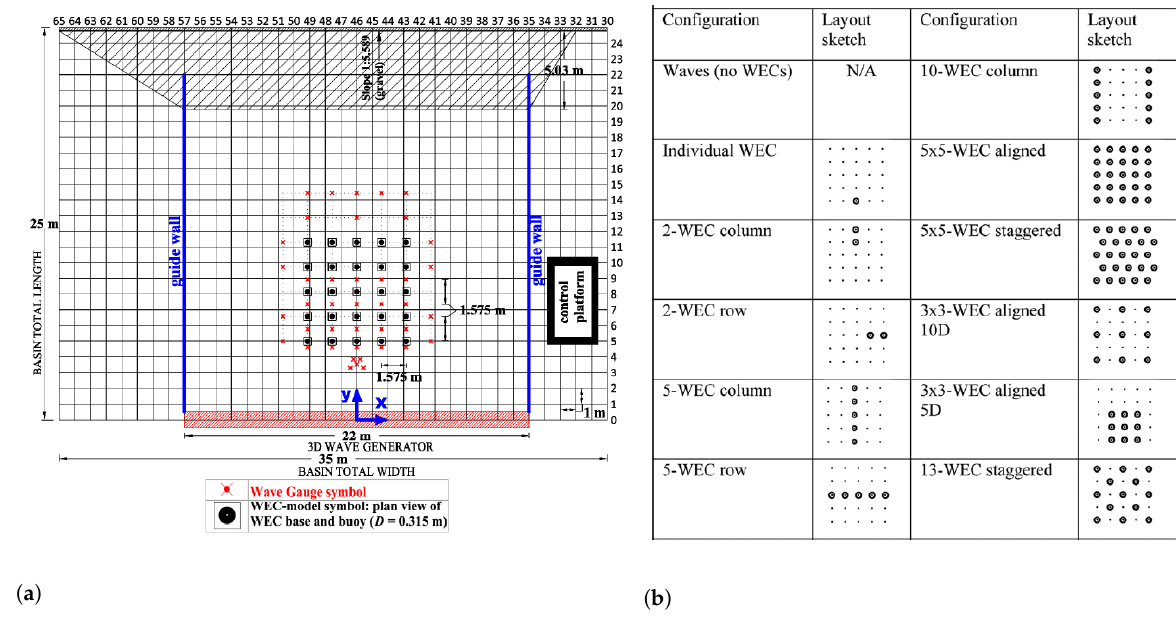
Figure 8. Experimental setup used by Stratigaki et al., adapted with permission from Ref. [11], 2015, Stratigaki et al.: ( a ) DHI’s wave basin 5 × 5 rectilinear WEC array layout; ( b ) sketches of tested WEC (array) configurations at the DHI’s wave